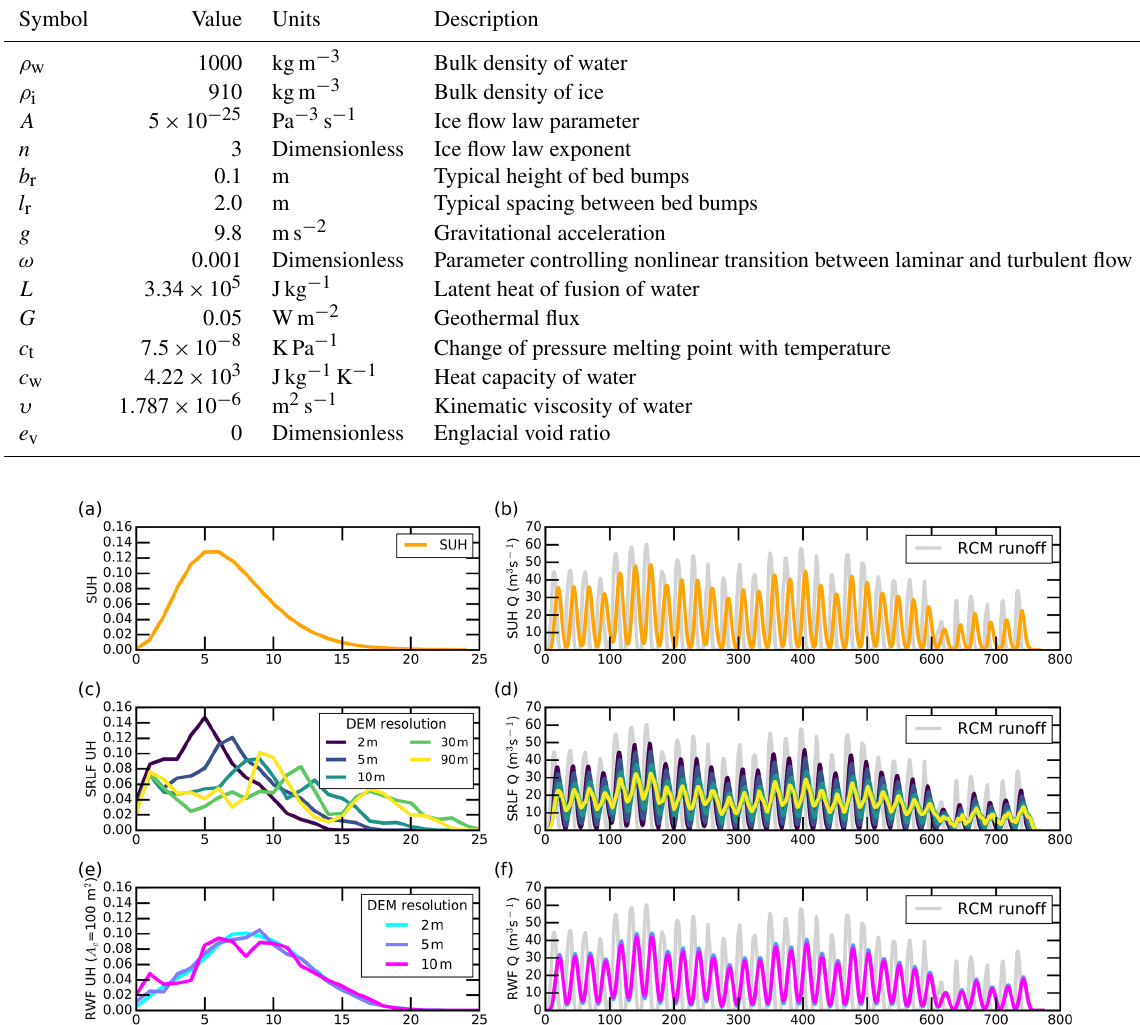
Figure 2. Presentation of unit hydrographs (UHs; column 1) and moulin discharges (column 2) of IDC1 during July 2015, as simulated by three surface meltwater routing models (SUH, RWF, and SRLF). Simultaneous RCM runoff (gray line) is shown to indicate the effect of surface meltwater routing processes on moulin